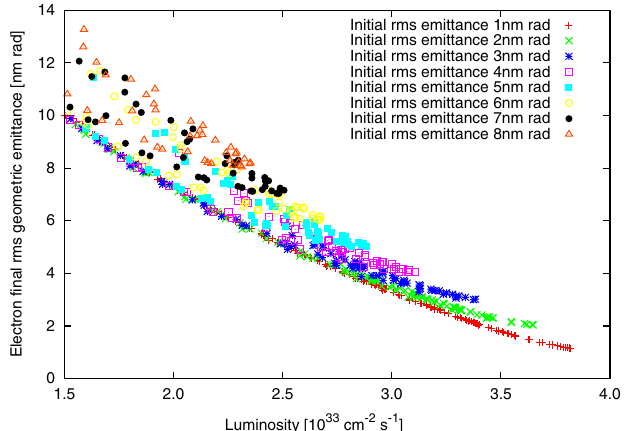
FIG. 12. (Color) Electron beam 100% effective emittance after collision as a function of luminosity.